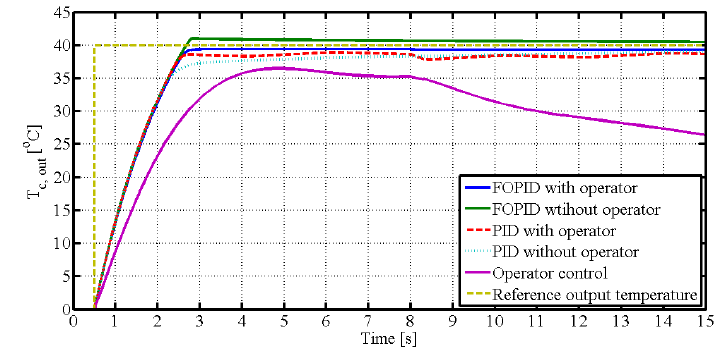
Figure 11. Comparison of different control schemes.